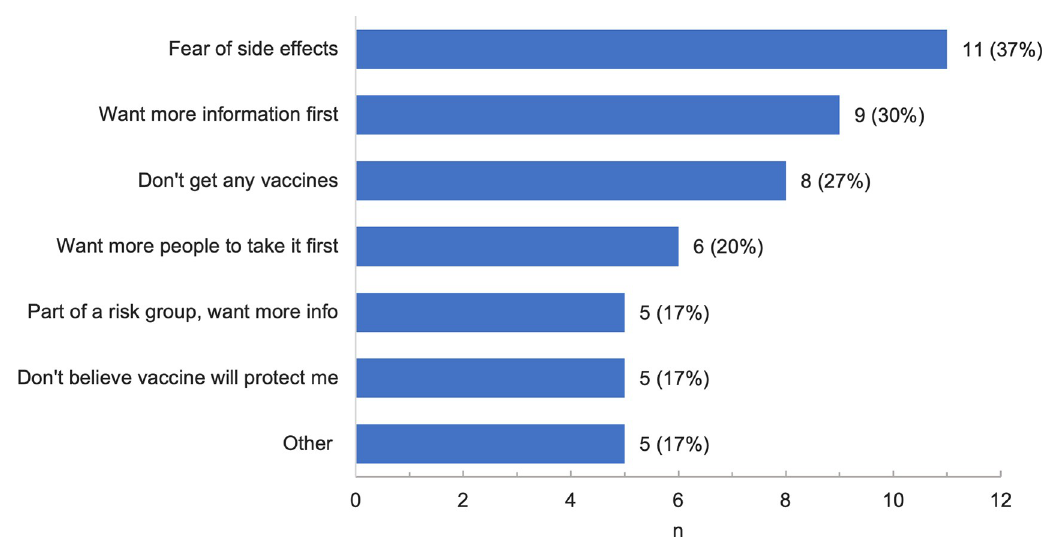
Fig 2. Reasons for vaccine hesitancy among those who refused offer of COVID-19 vaccine. Respondents who refused an actual or hypothetical offer of the COVID-19 vaccine were asked their reason(s) for refusal (n = 30). Other possible reasons for vaccine hesitancy that were not selected by any participants included “I am not at risk for COVID-19” and “I could not afford the vaccine”.